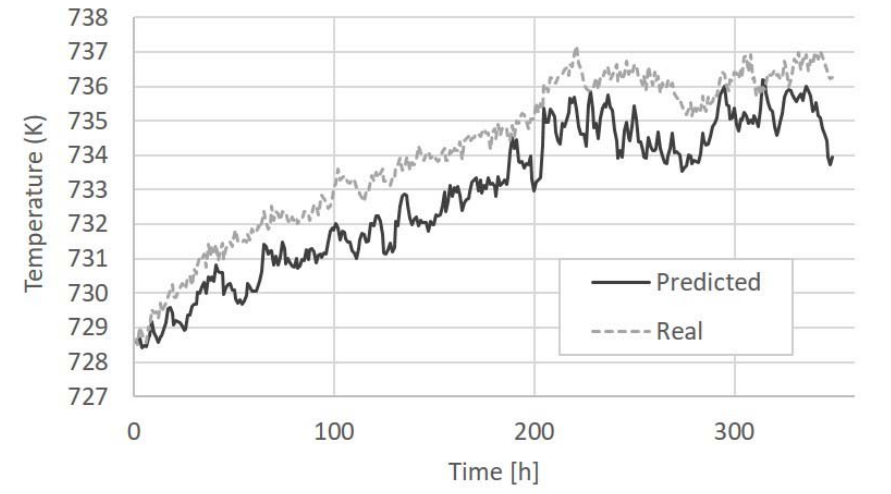
Figure 16. Predicted value of T3 vs. actual value.